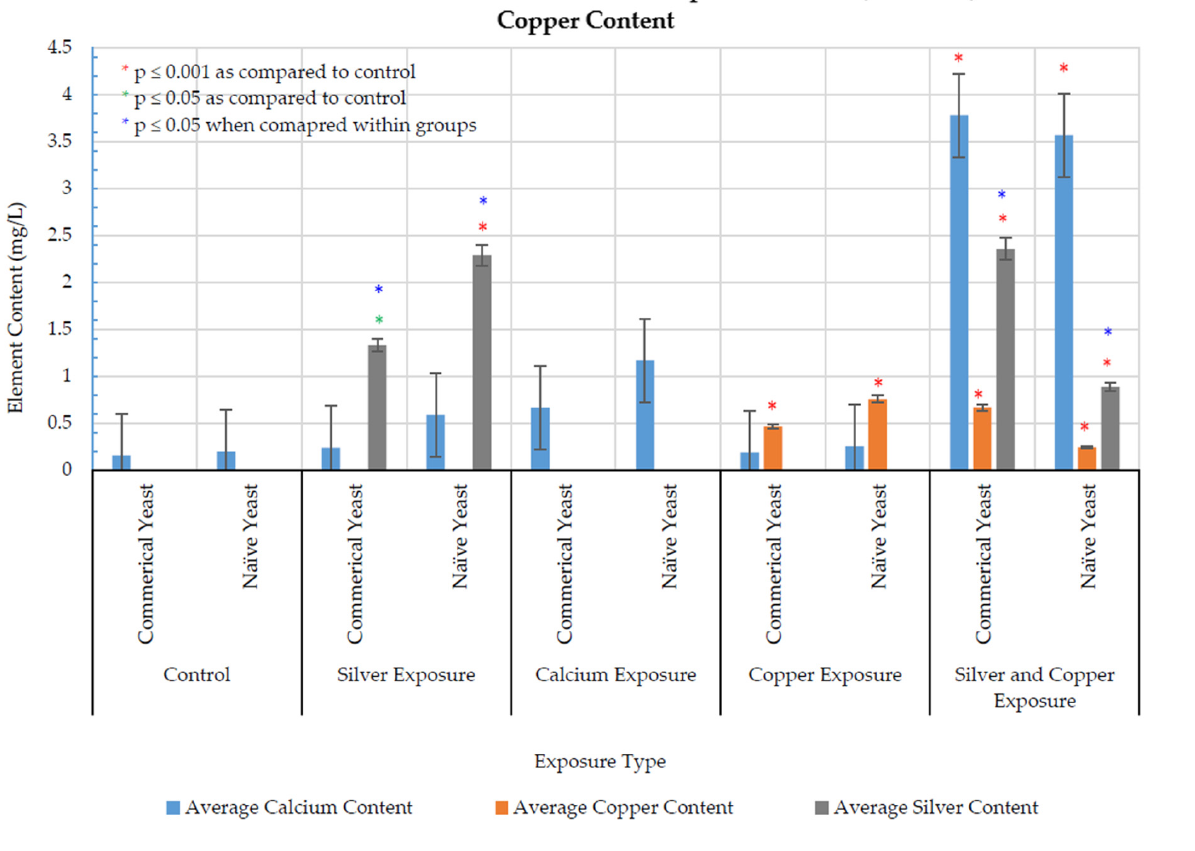
Figure 7. ICP-OES results of NS commercial ( n = 5) and NS naïve ( n = 5) yeast. Error bars represent percentage error